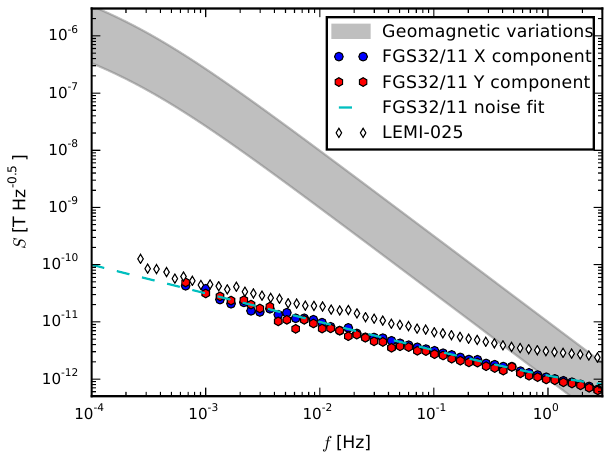
Figure 2. Noise spectra of fluxgate